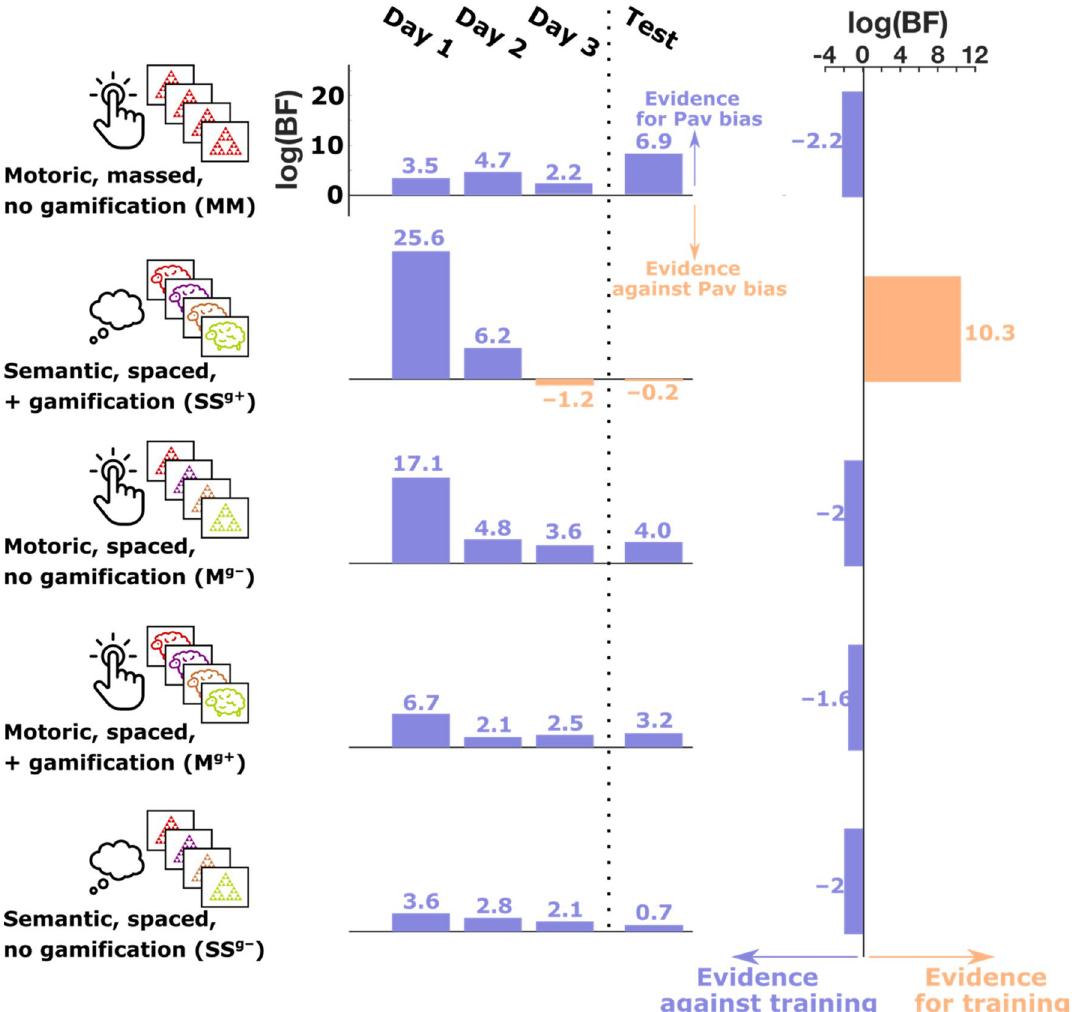
Figure 1. Summary of experiments and findings. Each of the five rows represents one of the five experiments. In each experiment, subjects played three training sessions on 3 consecutive days followed by a test session with a different task (the test task was SS g+ in experiment 1 and MM in all other experiments). The